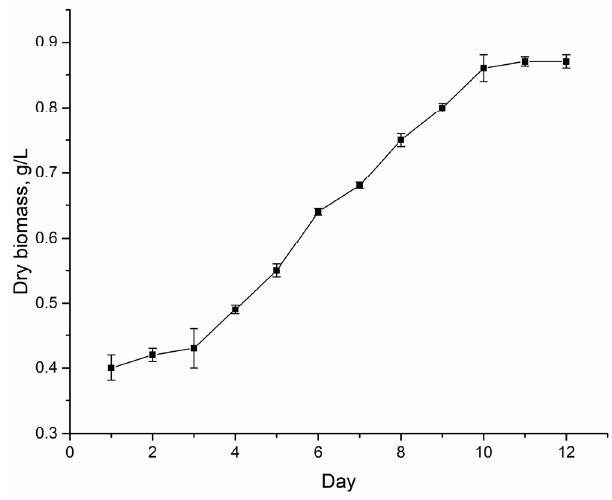
Figure 1. Growth curve of Nostoc linckia (Roth) Born et Flah CNM-CB-03 in standard conditions.